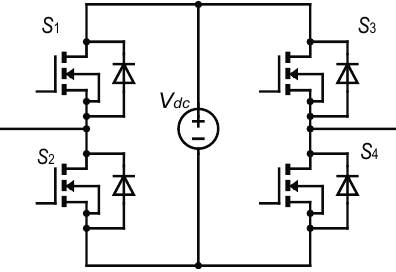
Figure 2. An H-bridge Used as an Edge in Lattice Converters.